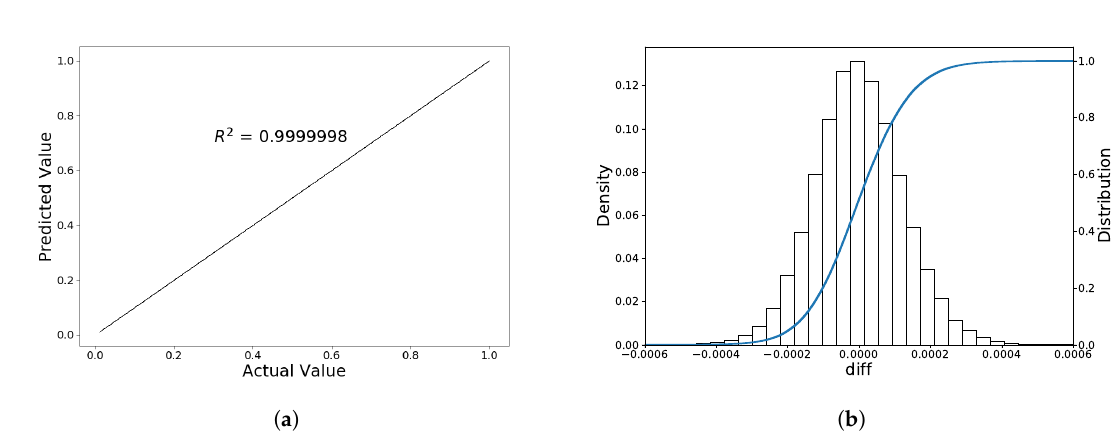
Figure 8. Out-of-Sample IV-ANN performance on the scaled input. ( a ) Comparison of implied volatilities; ( b ) The error distribution.